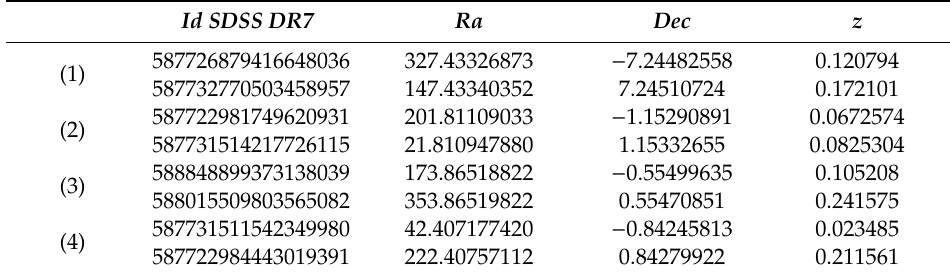
Table 4. Pairs of opposite galaxies for the e ff ect of cosmic lens [36]. Id SDSS DR7 is objID identification number in the Sloan Digital Sky Survey. Accuracy is of 0.0005 ◦ for ra and dec